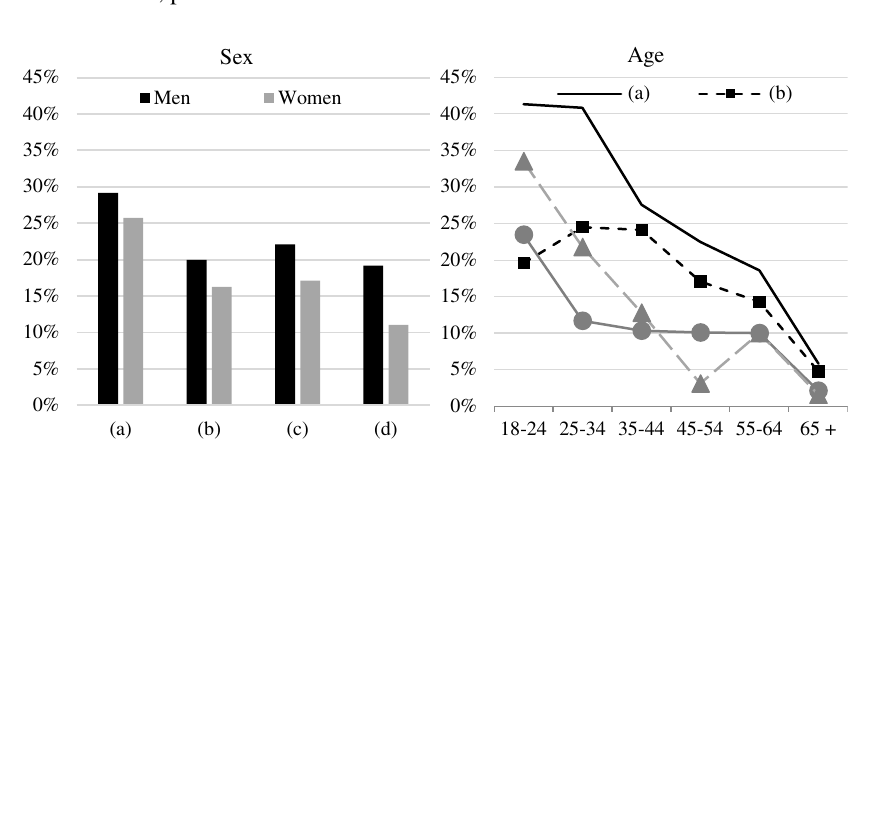
Figure 2. Migration intentions and sex, age, education, marital status, status on the labour market, place of birth and the financial